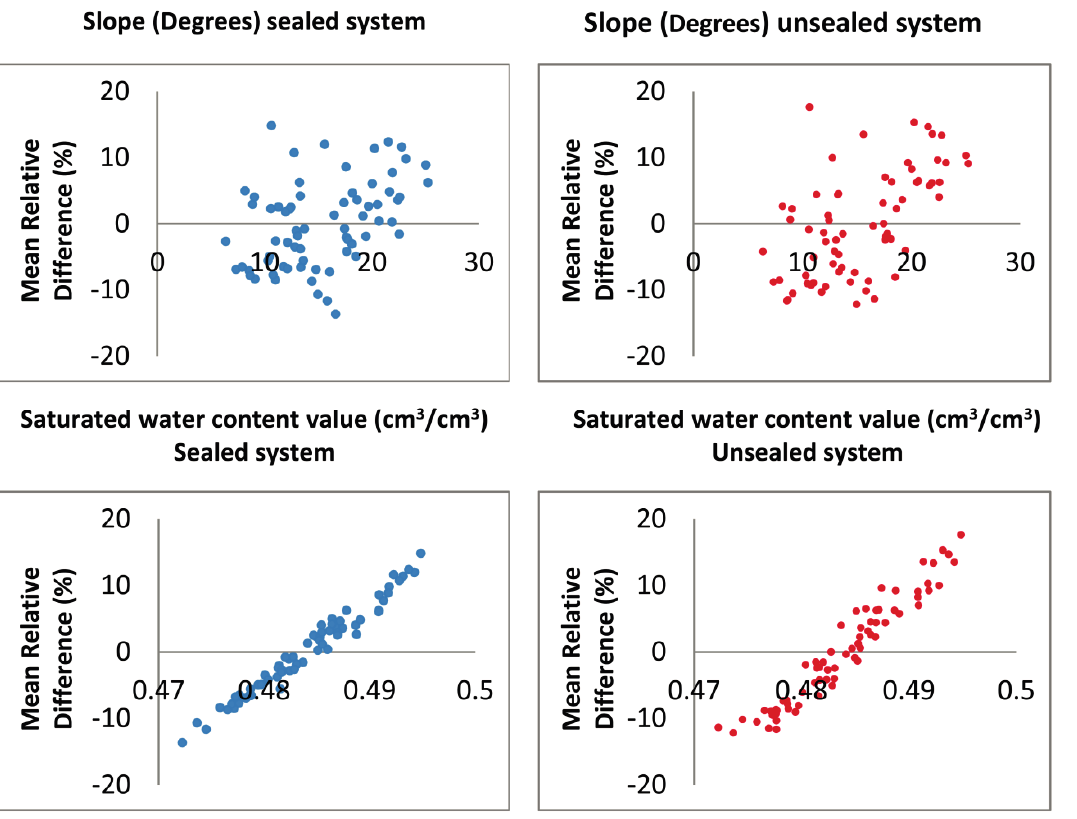
Figure 8. Relation between the mean relative differences (MRD) calculated for each 30-m cell based on 20 years of measured climate data and two explanatory variables: slope ( top ) and saturated water content value ( bottom ). The sealed and unsealed systems are marked in blue and red,